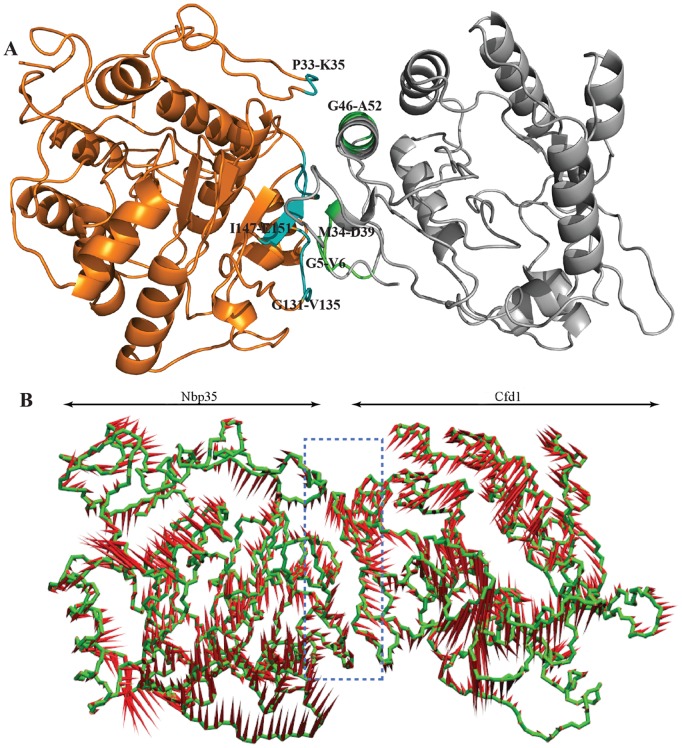
Nbp35-Cfd1 complex structure showing the regions involved in interaction.(A) Complex structure of Nbp35-Cfd1 where the molecular contacts are highlighted (blue–Nbp35) and (green-Cfd1) with mentioned residues involved in interaction. (B) Porcupine plots for Nbp35-Cfd1 complex showing backbone fluctuation from simulation time course. The regions involved in contact are highlighted with dotted region.